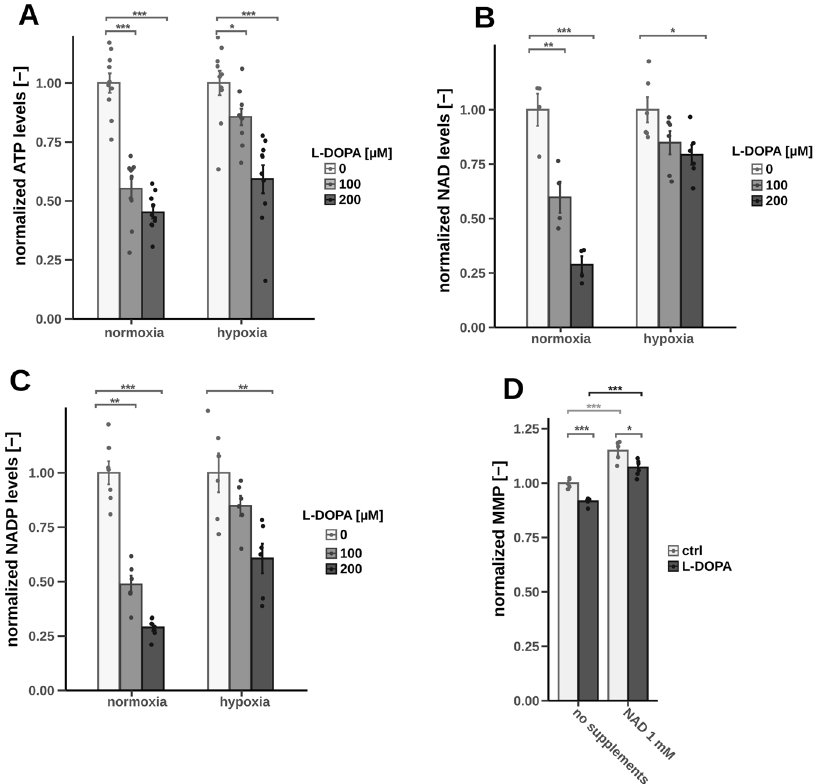
Fig. 5 Combined approach of selective permeabilization and stable isotope labeling after 2 h of L -DOPA treatment (200 µM) on fully differentiated LUHMES cells under normoxic and hypoxic conditions (signi fi cance levels were calculated using Welch ’ s t -test (* p -value < 0.05, ** p -value < 0.01), n = 3). A Schematic overview of the selective permeabilization via digitonin generating cell ghosts with intact mitochondria. B Schematic overview of the carbon transitions using the substrates 13 C 5 -glutamine and 12 C-pyruvate. C Reductive Gln fl ux calculated via the ratio of M5 citrate to M5 α -ketoglutarate. D Oxidative Gln fl ux calculated via the ratio of M4 citrate to M5 α -ketoglutarate. E Ratio between reductive and oxidative Gln fl ux calculated via the ratio of M5 citrate to M4 citrate. F SDH activity calculated via the ratio of M4 fumarate to M4